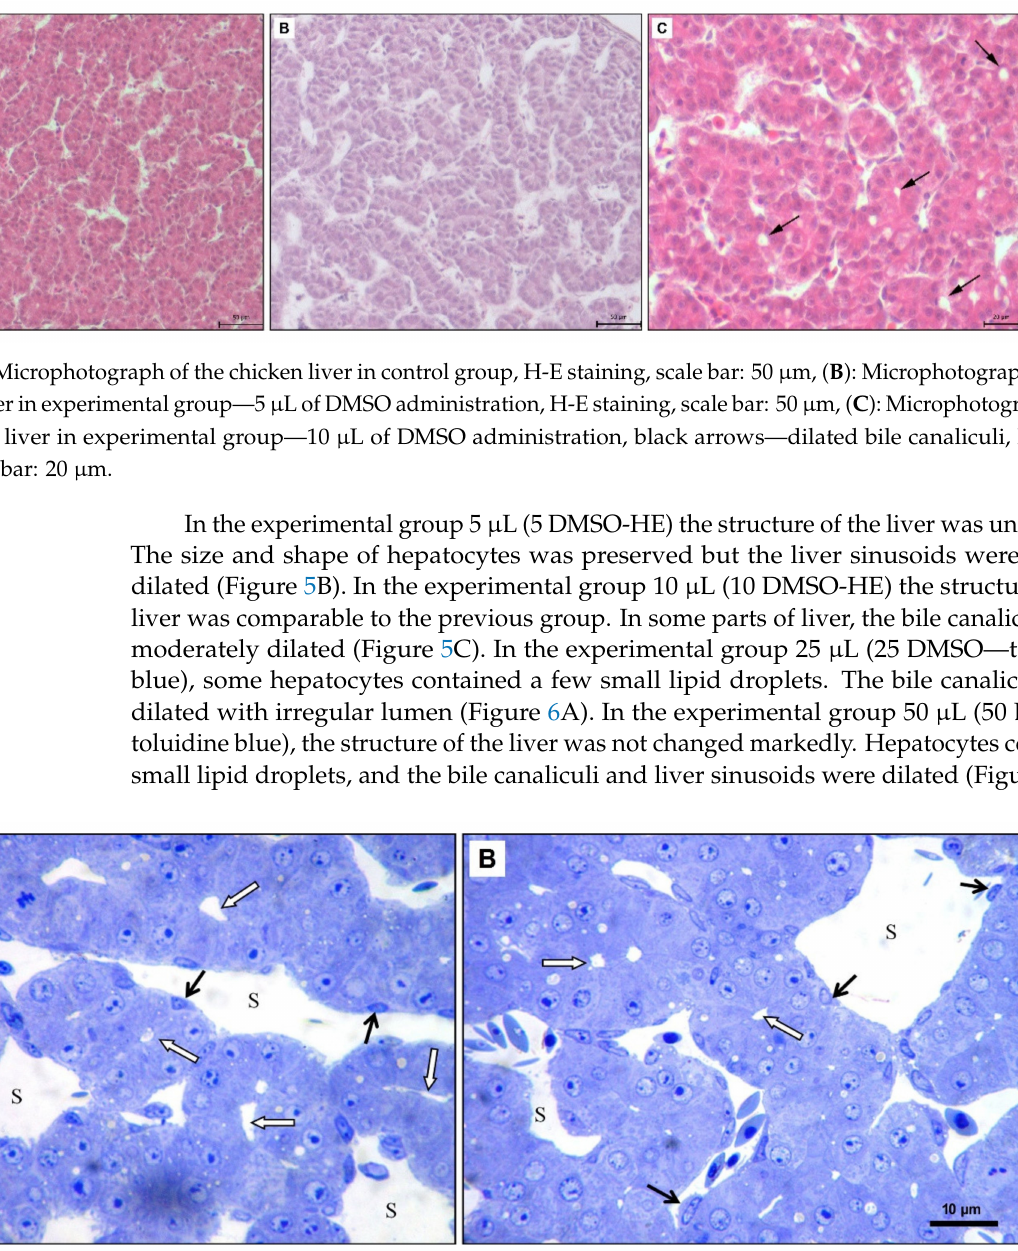
Figure 6. ( A ): Microphotograph of the chicken liver in experimental group—25 µ L of DMSO administration, scale bar: 10 µ m, ( B ): Microphotograph of the chicken liver in experimental group—50 µ L of DMSO administration, scale bar: 10 µ m; S—liver sinusoid, black arrows—endothelial cells, white arrows—dilated bile canaliculi, Toluidine blue